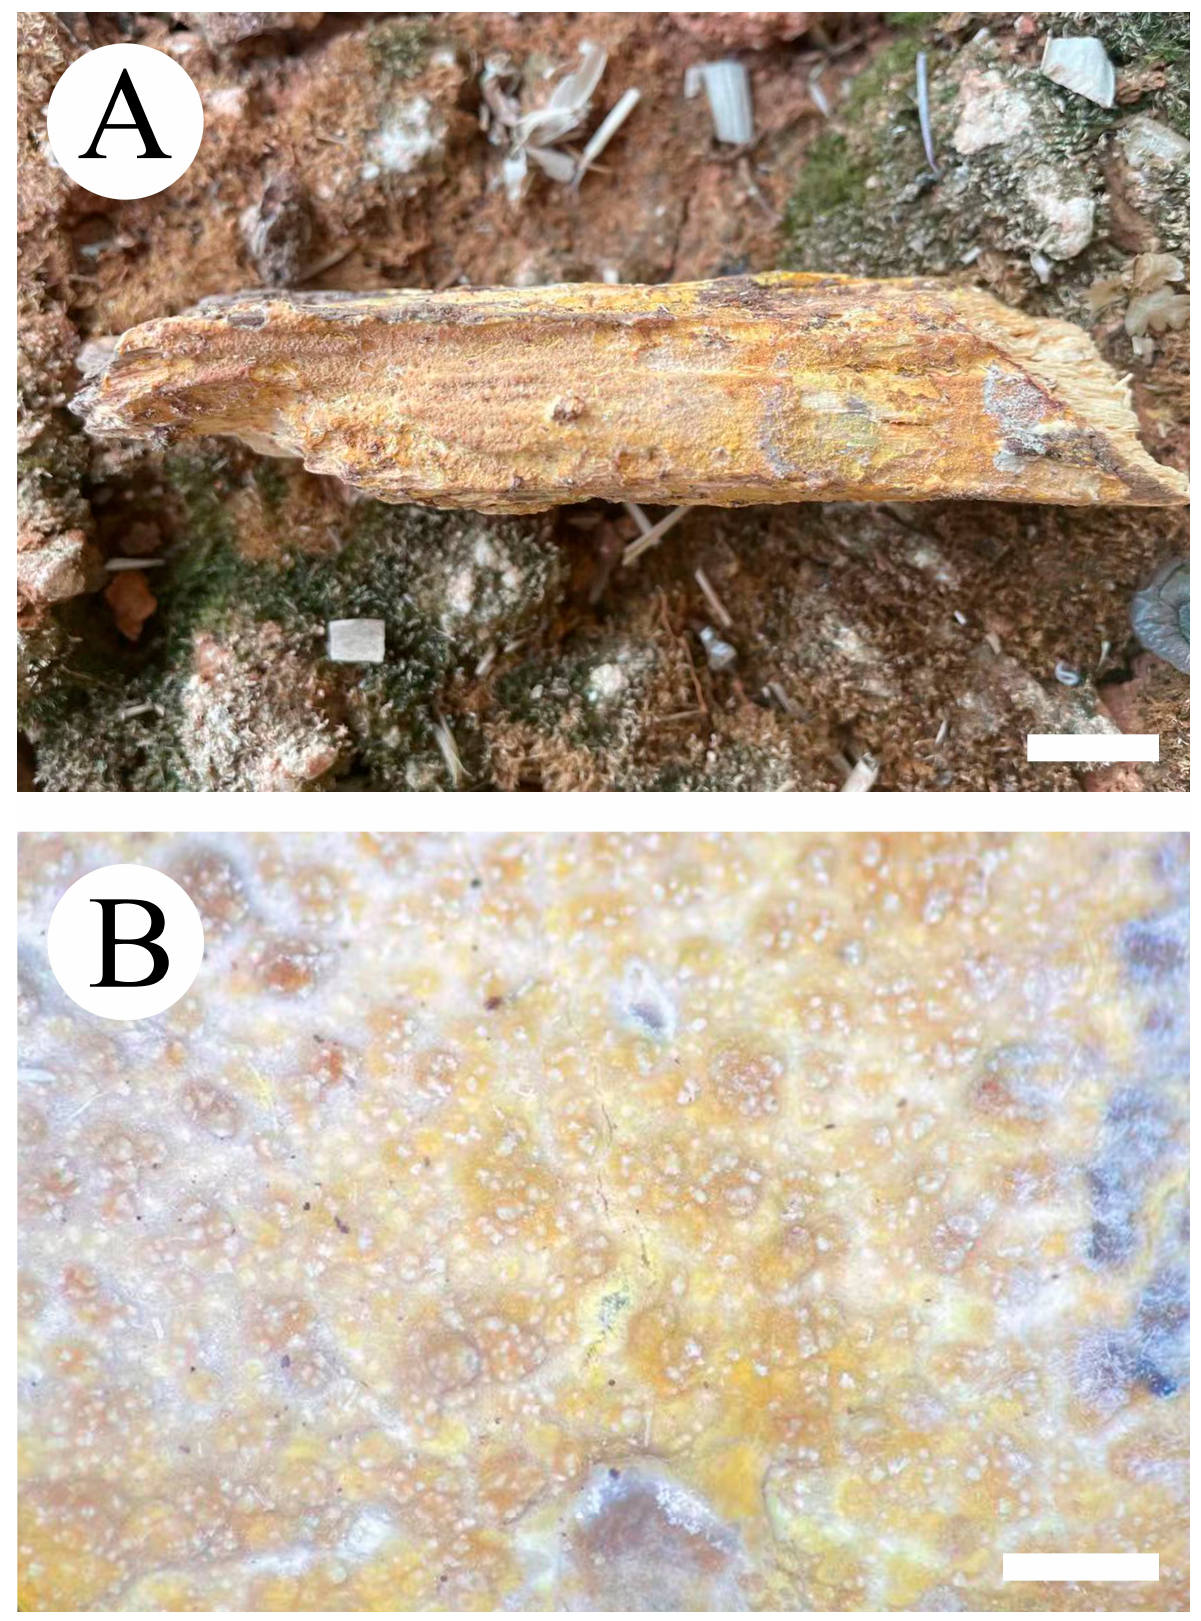
Figure 7. Basidioma of Luteoporia straminea (CLZhao 18947, holotype). Bars: ( A ) = 1 cm, ( B ) = 1 mm.